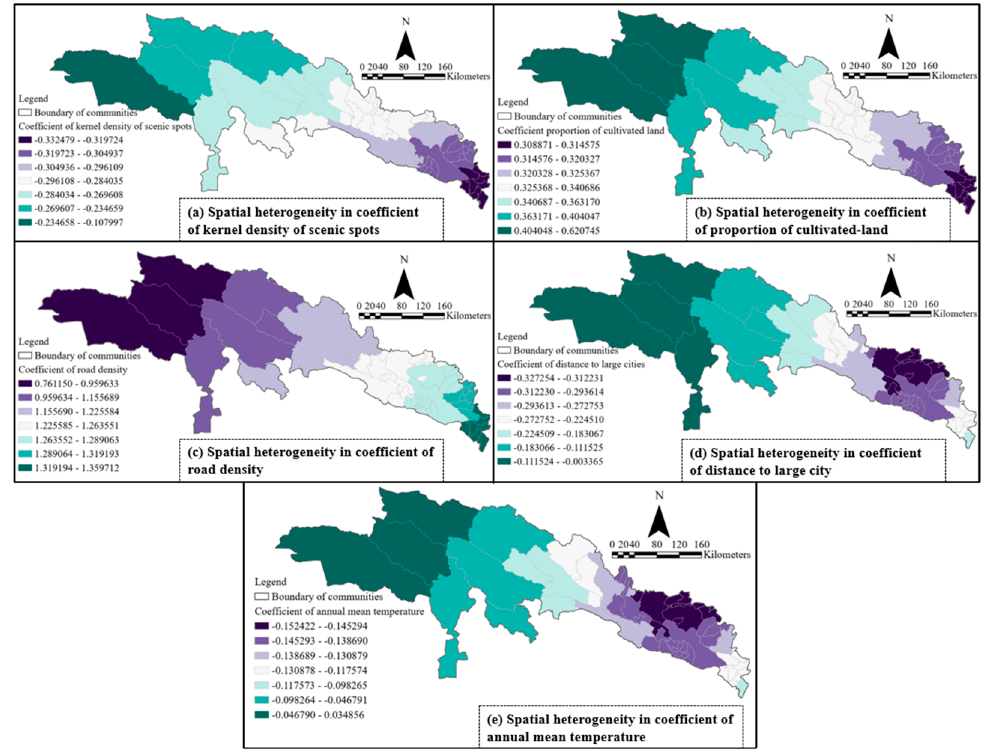
Figure 9. The spatial heterogeneity in the coefficients of independent variables based on the PD as the dependent variable.